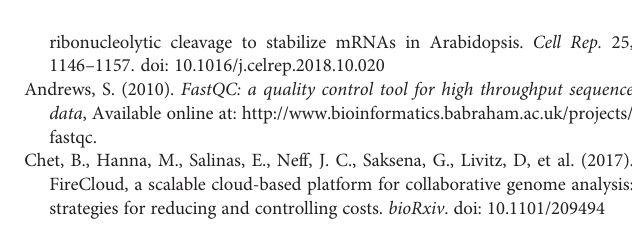
TABLE S1 | SRA IDs, tissue information, and mapping rates of example data. FILE S1 | Script used to calculate transcript length and GC